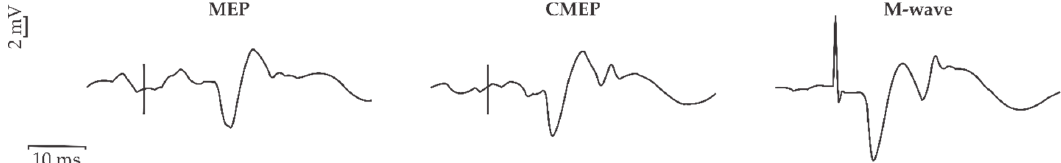
Figure 3. Raw data sample for MEP, CMEP and Mmax responses during an MVC from a single participant.